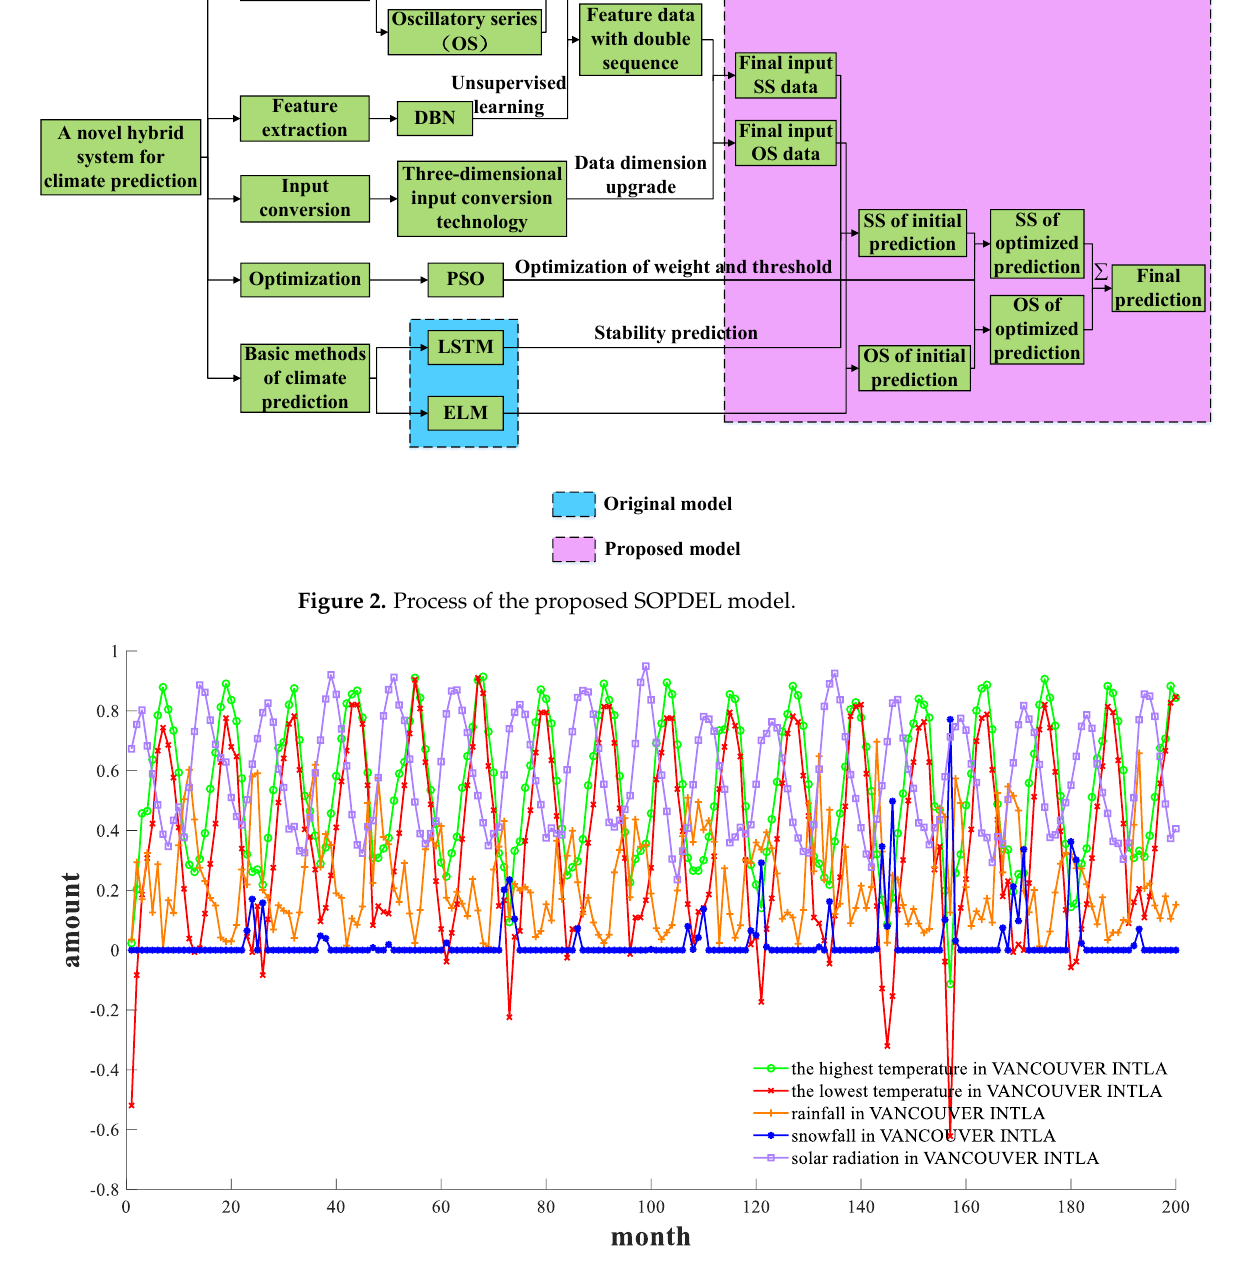
Figure 3. Normalized raw data for the one region studied for climate prediction.